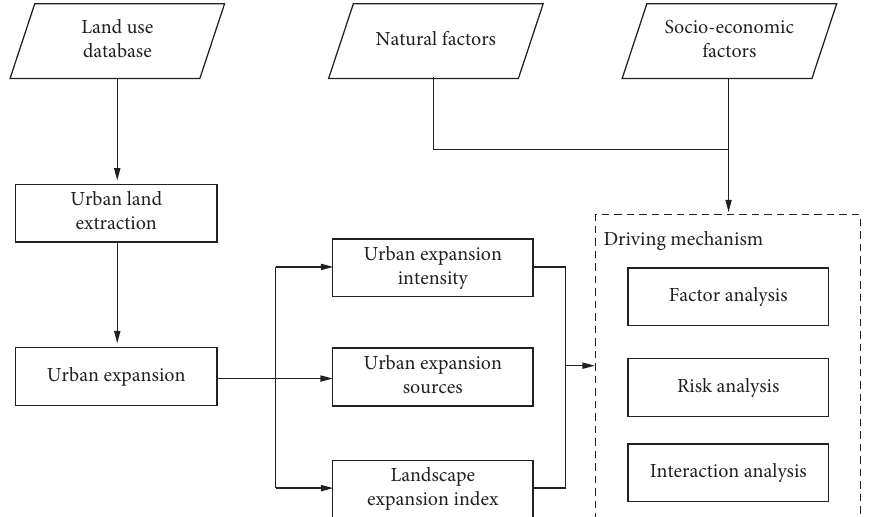
Figure 2: A schematic overview of research